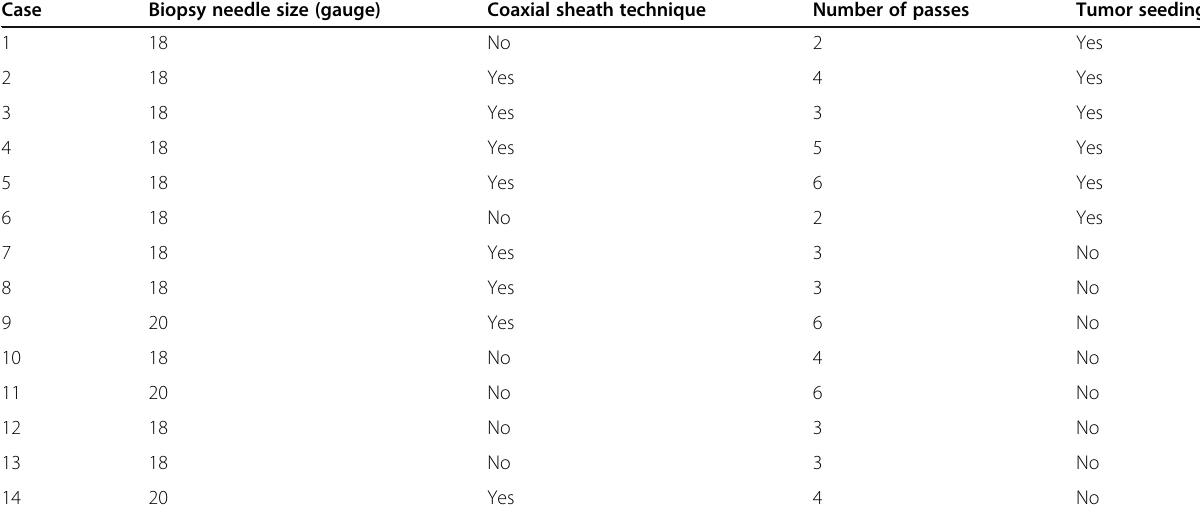
Case Biopsy needle size (gauge) Coaxial sheath technique Number of